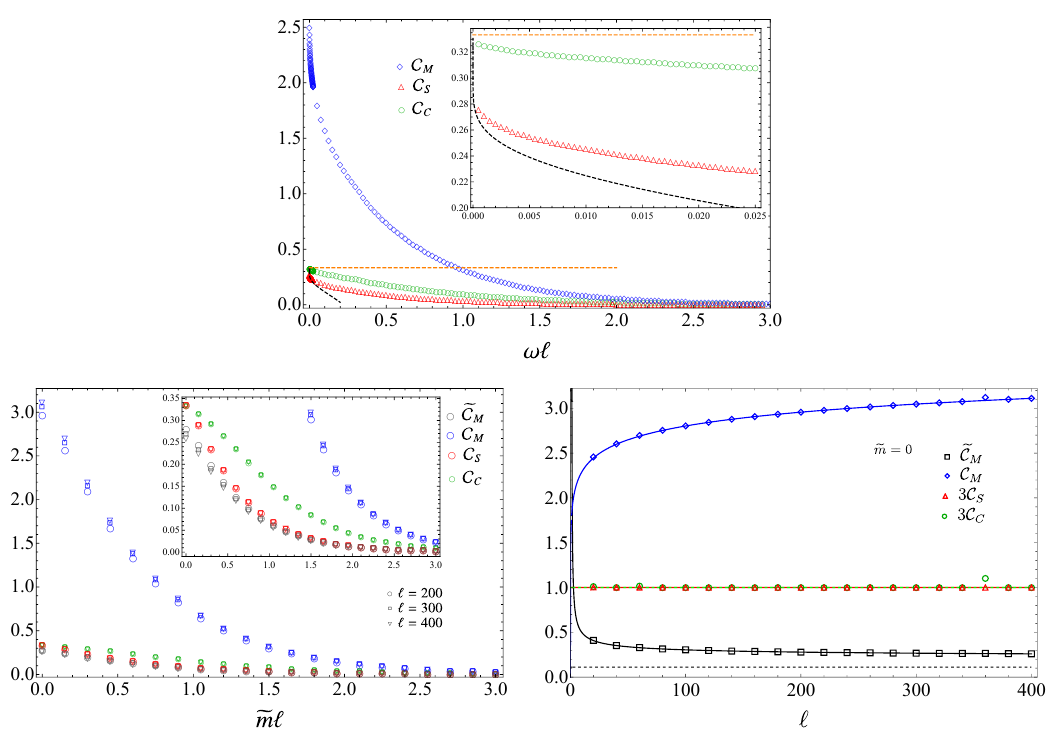
Figure 3 . The c -functions (3.1), (3.14), (3.15) and (3.16). In the top panel we compute them for the harmonic chain as function of ω‘ with ‘ = 100 . The black dashed curve is obtained from (3.19), while the orange dashed line corresponds to the constant 1 . In the bottom panels we consider the 3 discretisation of the massive Dirac field theory. In the bottom left panel the data points are plotted as function of m‘ , while in the bottom right panel are reported as function of ‘ with m = 0 . The e e green and red horizontal lines correspond to the constant 1, while the blue and the black curves are given by the the first and the second expression in (3.26) respectively with (cid:15) = 1 . The horizontal black dashed line is the constant 1 . In all the panels for the discrete derivatives of the numerical 9 data (3.17) has been